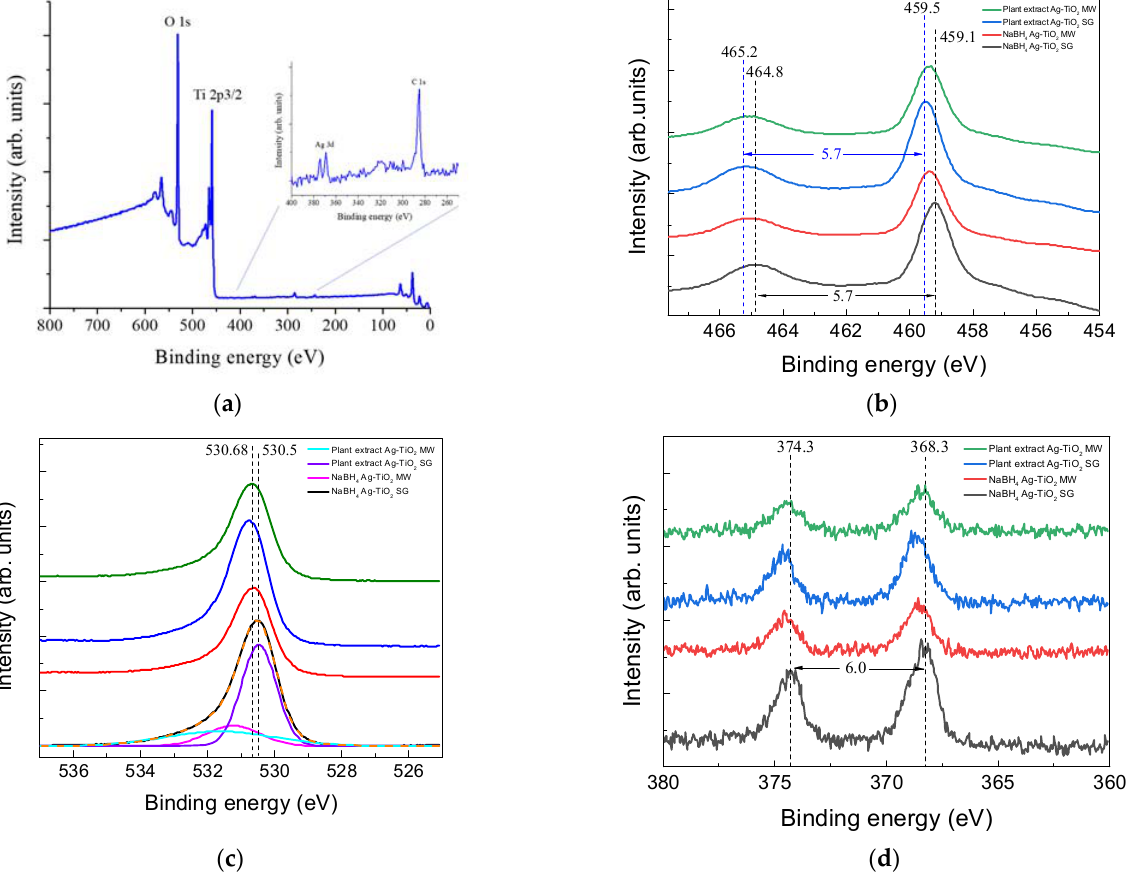
Figure 10. XPS spectra of Ag-TiO 2 materials: ( a ) survey, ( b ) titanium, ( c ) oxygen, and ( d ) silver.